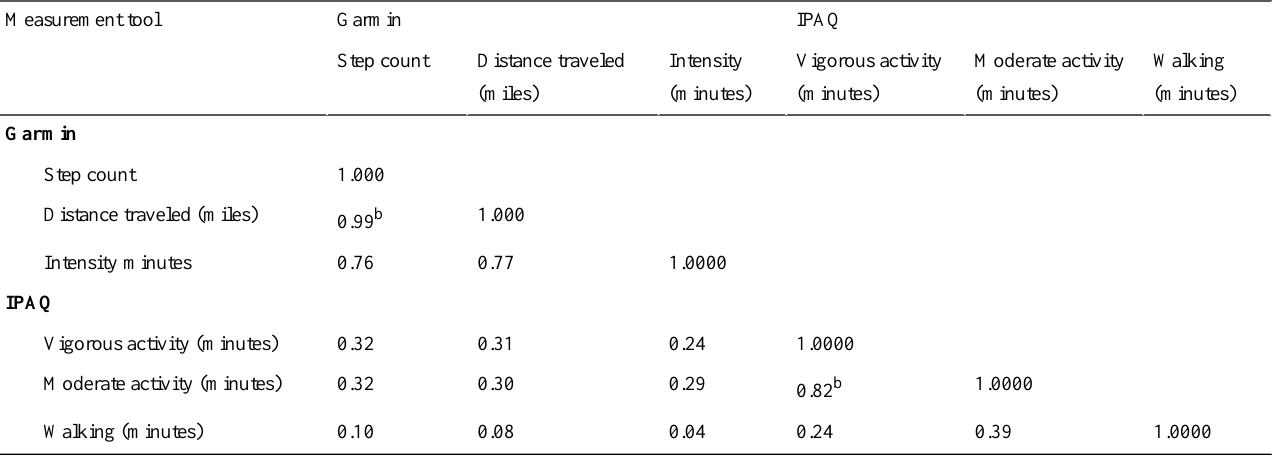
Table 3. Pearson correlation of average activity monitor data and IPAQ-SF a responses. IPAQGarminMeasurement